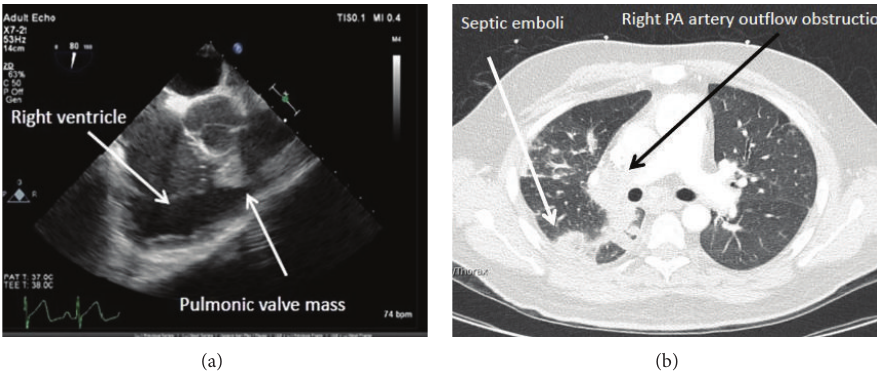
Figure 1: (a) Transesophageal echocardiogram demonstrating a large mass in the right ventricular outflow tract during diastole. (b) CT angiography of the chest showing a right PA artery outflow obstruction and septic pulmonary emboli.